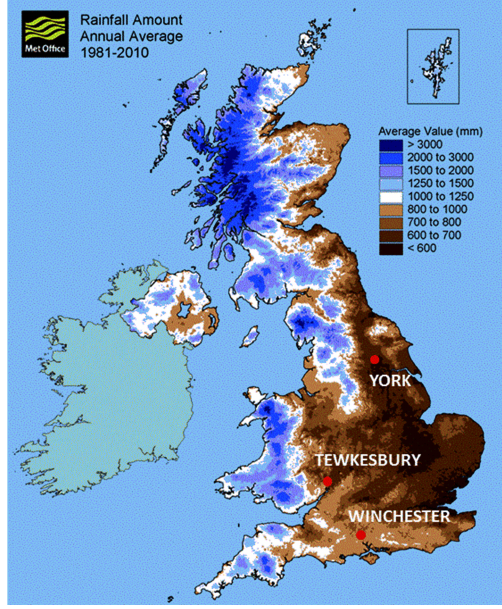
Fig. 2. Annual average precipitation map of the UK showing loca- tion of three case study sites.